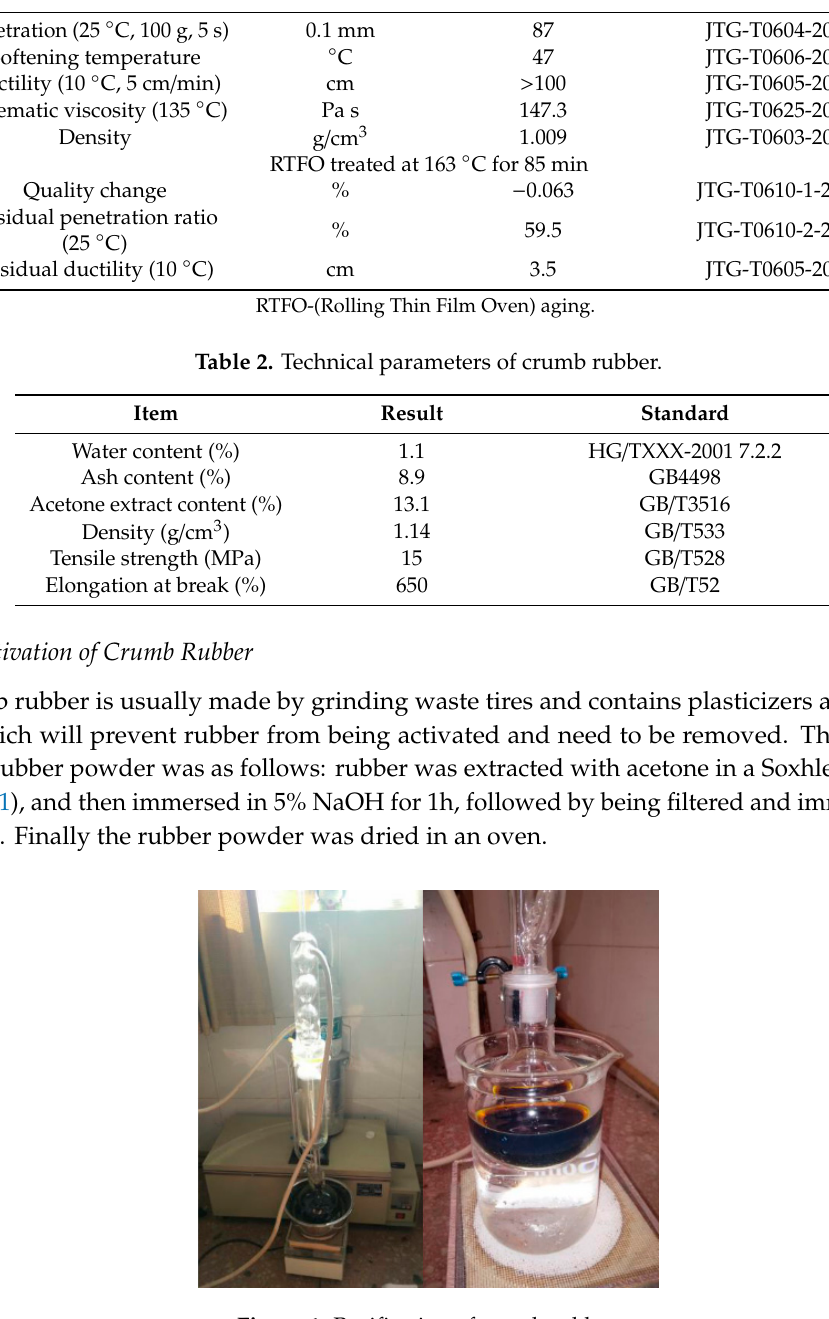
Table 3. Samples of asphalt binder. Sample